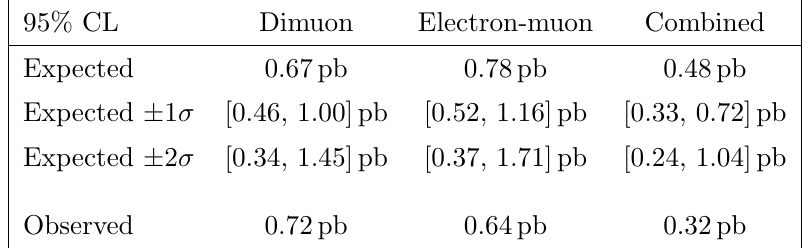
by a blue line. The observed and expected limits are consistent within the statistical (cid:13)uctuations since the observed limits are within the green (68%) or yellow (95%) bands of the expected limit values. The observed limits for the combined analysis are more stringent than the limits from the individual (cid:12)nal